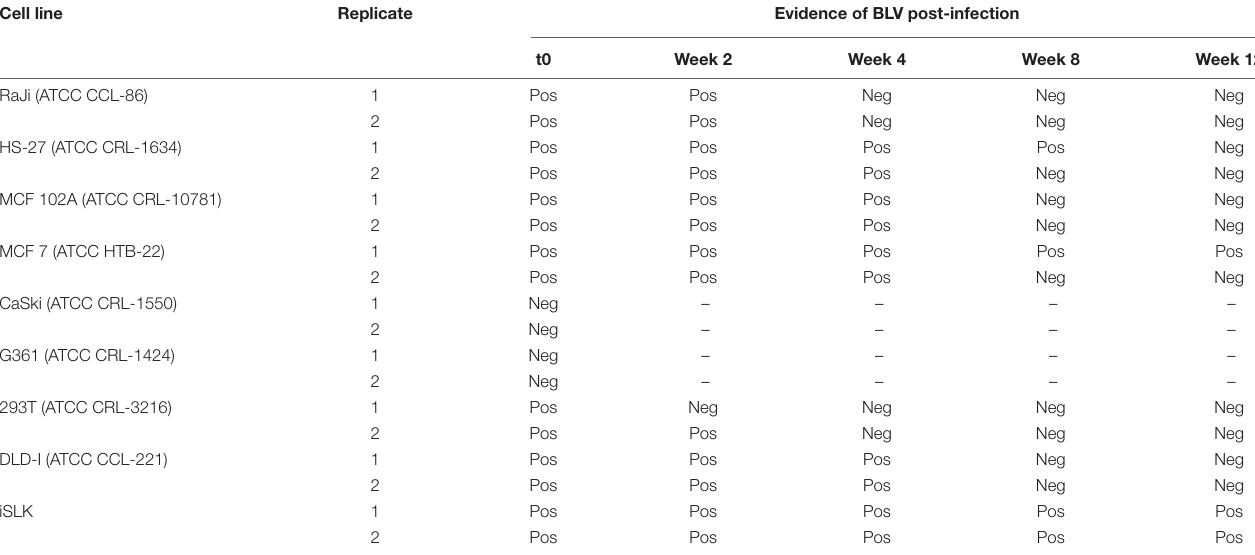
TABLE 2 | Evidence of BLV-GRE genomic region in human cell lines after infection through nPCR in a follow-up of 12 weeks post-infection. Cell